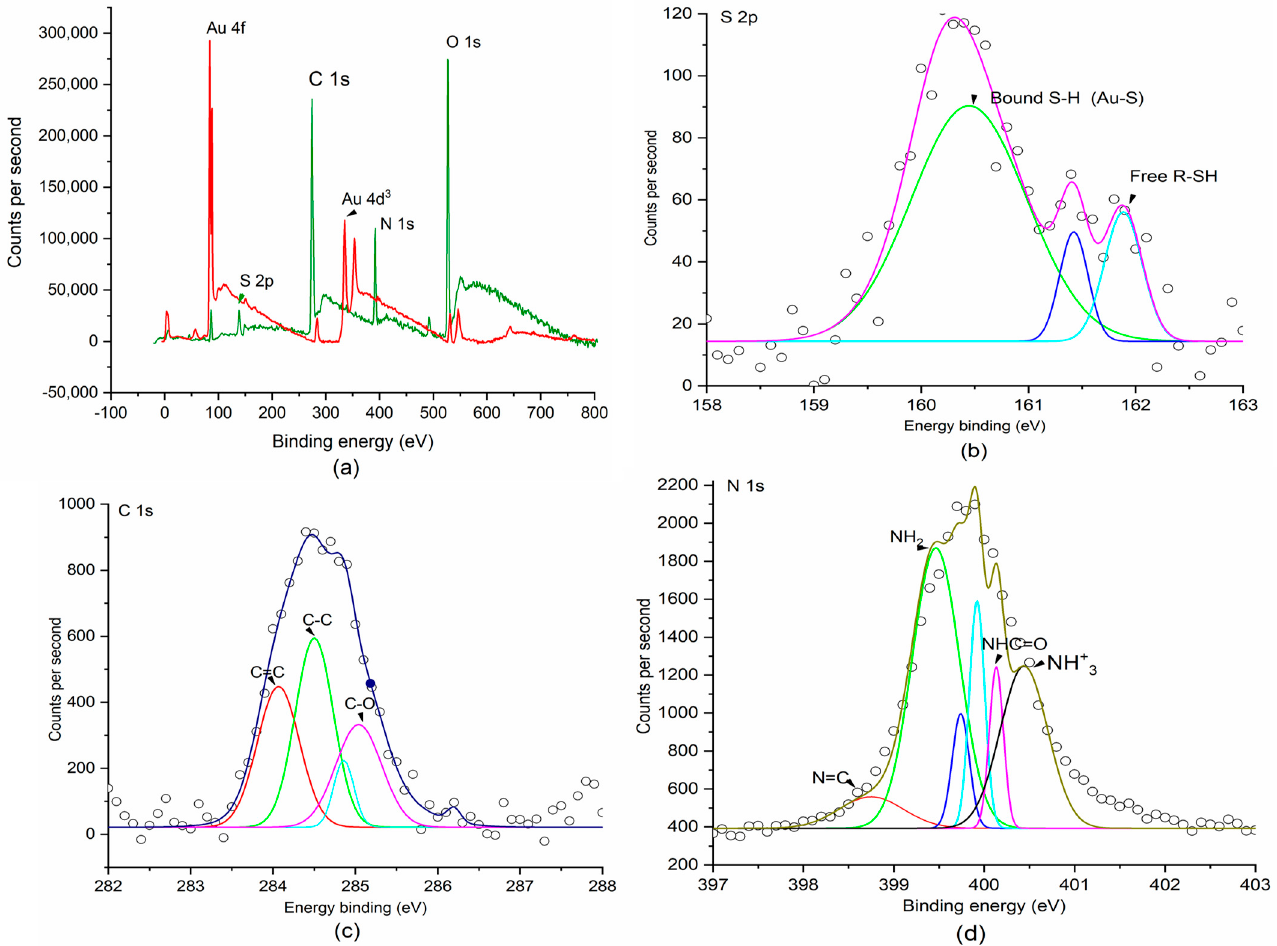
Figure 3. Binding energy evaluation of elements on the electrode surface. ( a ) X-ray photoelectron Scheme 2, ( b ) S 2p, ( c ) C 1s, and ( d ) N 1s. Al K α radiation used to observe matching peak intensities for the binding energy scan.